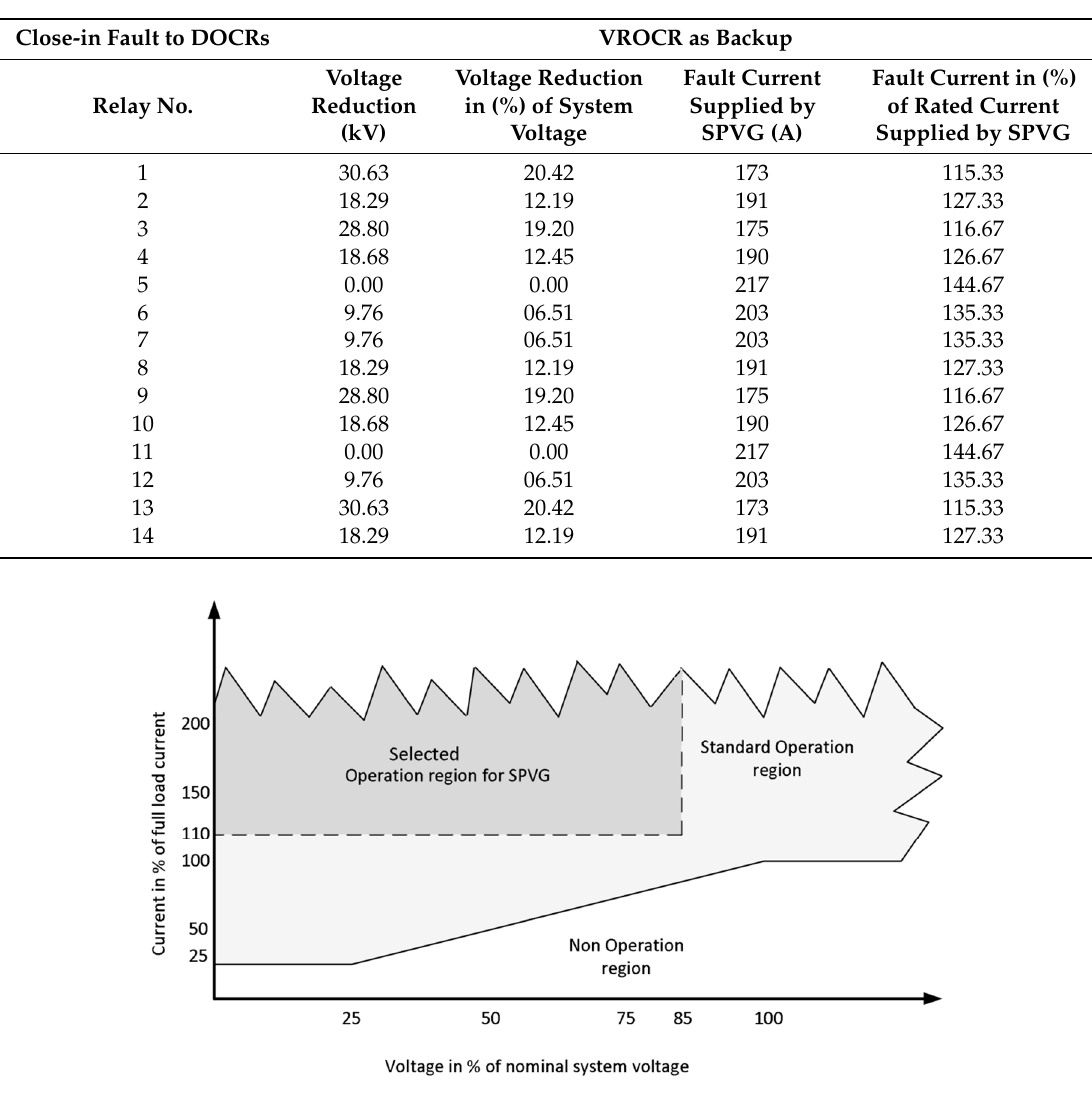
Figure 3. Voltage-restrained overcurrent relay (VROCR) operating characteristics based on pickup settings of current and voltage for SPVG protection.